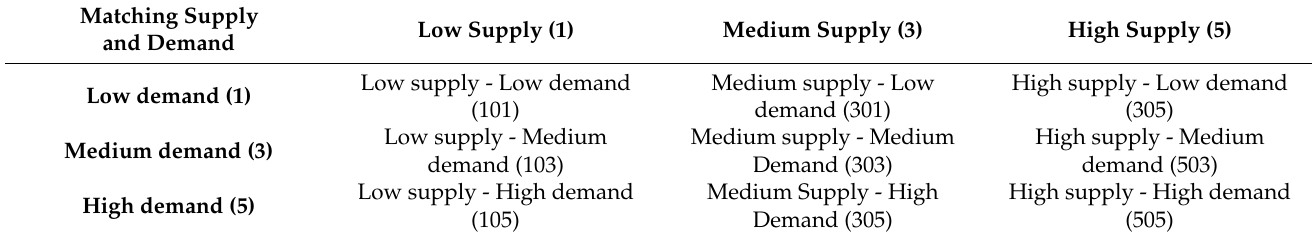
Table 3. Supply and demand matching